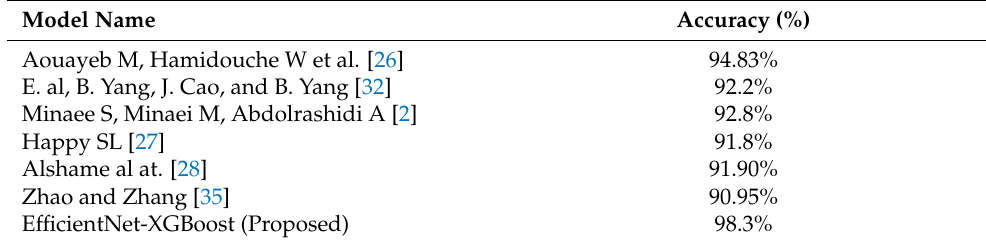
Table 9. Accuracy of JAFFE Dataset.